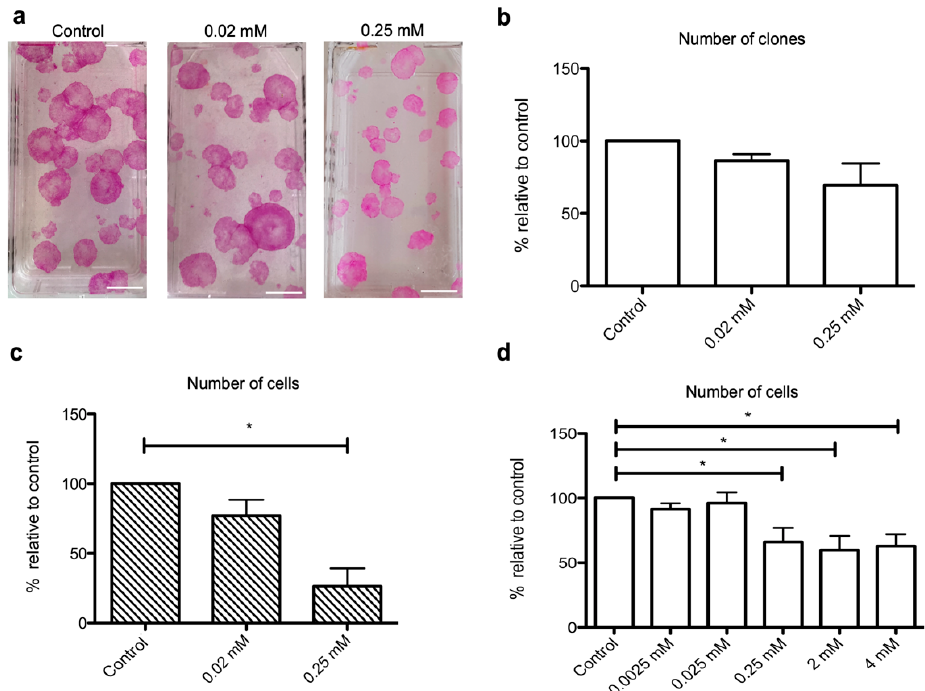
Figure 2. NaHS impairs the growth of human epidermal stem cells and epidermal cell sheets. ( a–c ) Human keratinocytes cultured under clonogenic conditions were stimulated every other day with NaHS at 0.02 or 0.25 mM concentrations during 12 days. Cells were then fixed and stained with hematein–eosin, allowing colonies of keratinocyte stem or progenitor cells to be manually counted. Keratinocyte cultures generated in parallel under strictly identical conditions were trypsinized, and living cells were numerated following trypan blue staining. Four keratinocyte cultures deriving from four distinct donors were used in these experiments. ( a ) Representative images of grown colonies obtained under control condition (upper panel) or under NaHS stimulation at 0.02 mM concentration (middle panel) or 0.25 mM concentration (lower panel). Images show that, as compared to control untreated cells or cells treated with 0.02 mM NaHS, colonies are of lower size in cells treated with 0.25 mM NaHS ( b ) Irrespective of NaHS concentration, the total number of colonies remains unchanged in NaHS-treated cells as compared to control cells. ( c ) However, the total number of harvested living cells is significantly lower in cultures treated with 0.25 mM NaHS as compared to control untreated cultures. ( d ) The effects of NaHS on the cellular density of epidermal cell sheets were assessed after 24h treatment with NaHS at concentrations ranging from 0.0025 mM to 4 mM. Experiments were performed on cells obtained from six distinct donors. Results are expressed as percentages relative to control conditions. Statistical significance of paired comparisons was assessed with the Wilcoxon test. *: p < 0.05. Scale bar: 1 cm.